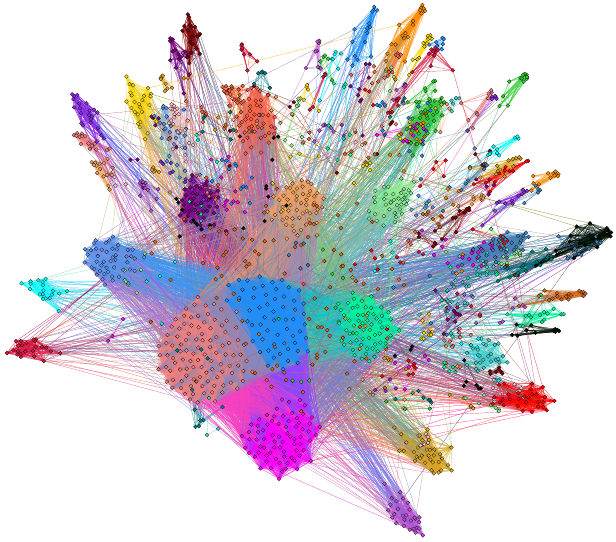
Figure 6. BTER Scale-Free network generated by